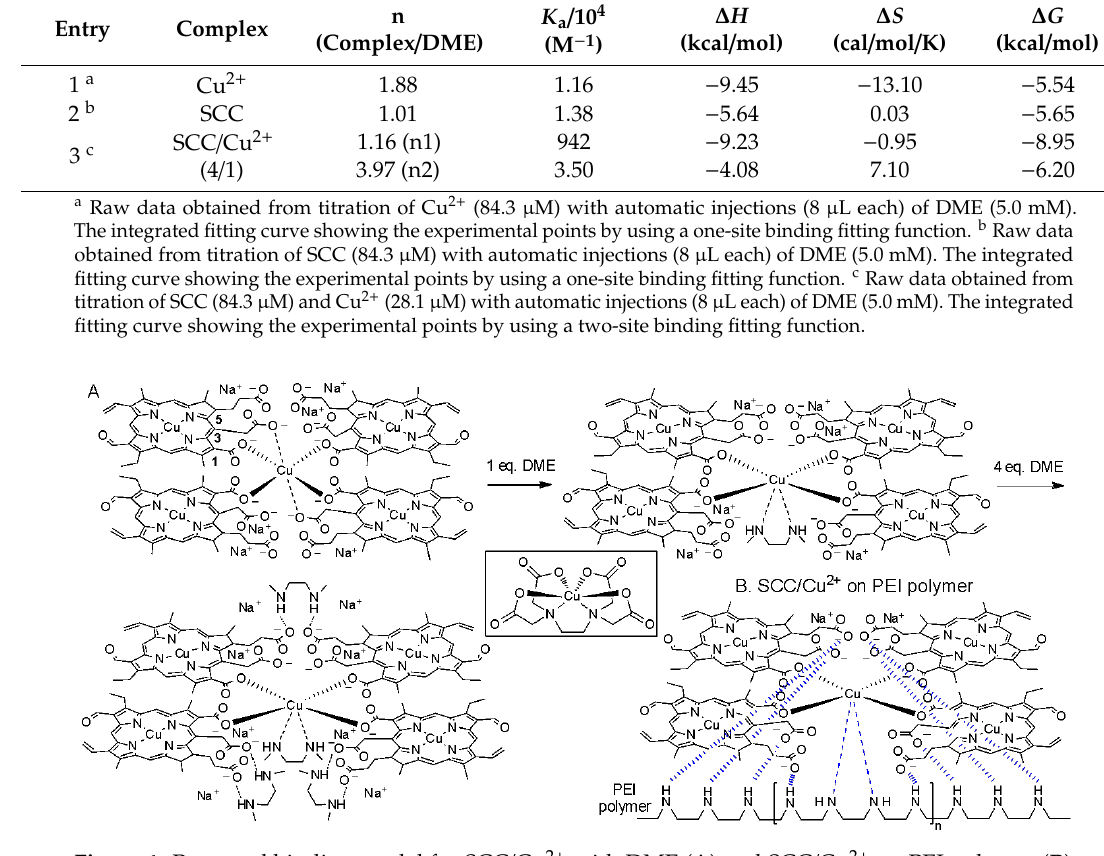
Figure 4. Proposed binding model for SCC/Cu 2+ with DME ( A ) and SCC/Cu 2+ on PEI polymer ( B ). Inset: structure for the complexation of EDTA/Cu 2+ . Table 3. FT-IR vibration wavenumbers (cm −1 ) for the carboxylate groups of SCC, SB, and SC with or without Cu(ClO 4 ) 2 and DME. a.